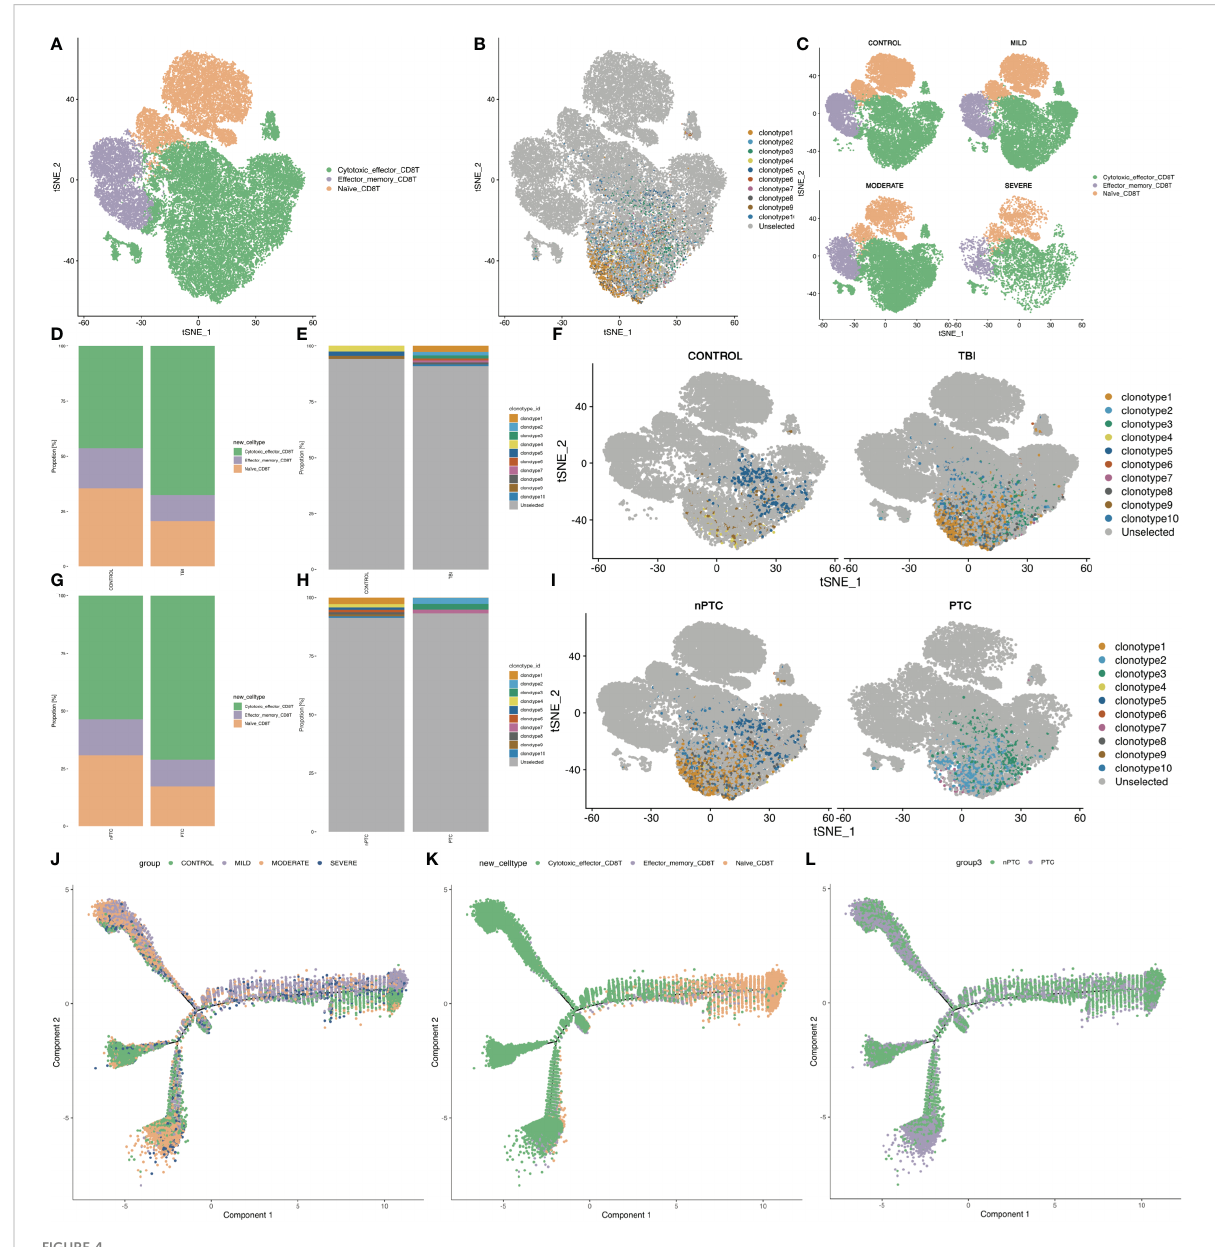
FIGURE 4 The subpopulations of CD8+ T cells and CD8 T clone of PBMCs in TBI patients. (A) The three clusters of CD8+ cells in the t-SNE map. (B) The TCR clone in each CD8+ cell cluster. (C) The t-SNE map shows the different distributions of three clusters in control, mild, moderate, and severe TBI. (D – F) t-SNE map shows the clone expansion between TBI and control and quanti fi cation of the proportion of TCR clonotype in each group. (G – I) t-SNE map shows the clone expansion between nPTC and PTC groups; and quanti fi cation of the proportion of TCR clonotype in each group. (J – L) Pseudo-time analysis for CD8 subsets between control vs. TBI and nPTC vs. PTC